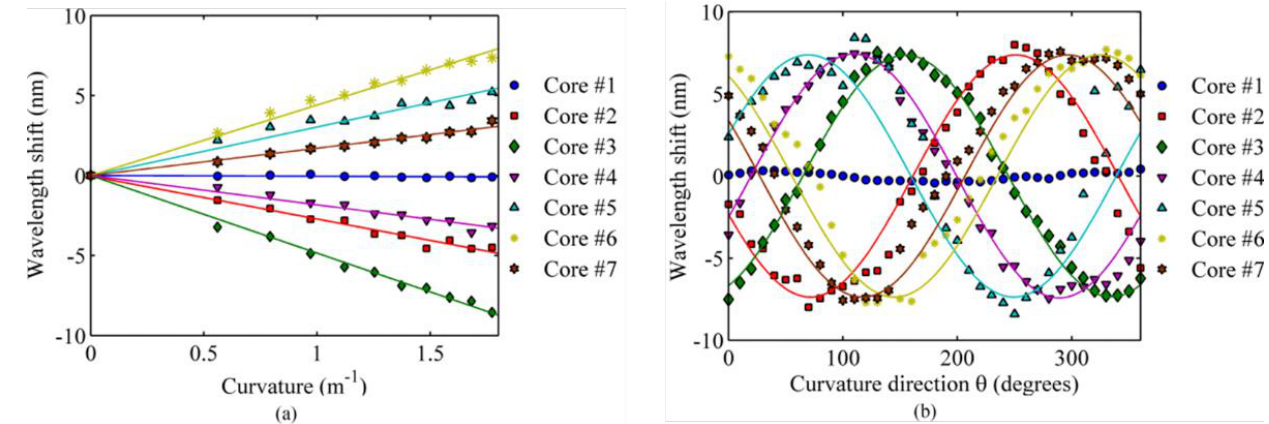
Figure 22. ( a ) Wavelength shift with the curvature magnitude. ( b ) Wavelength shift with curvature direction at a constant curvature of 1.25 m − 1 . Adapted with permission from Ref. [108] © IEEE.